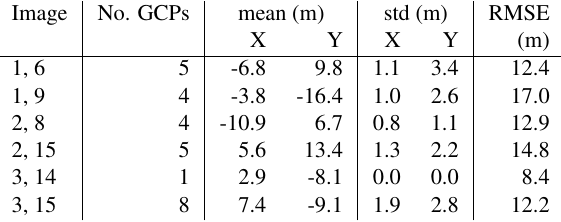
Table 3: Planimetric GCP errors after adjustment.